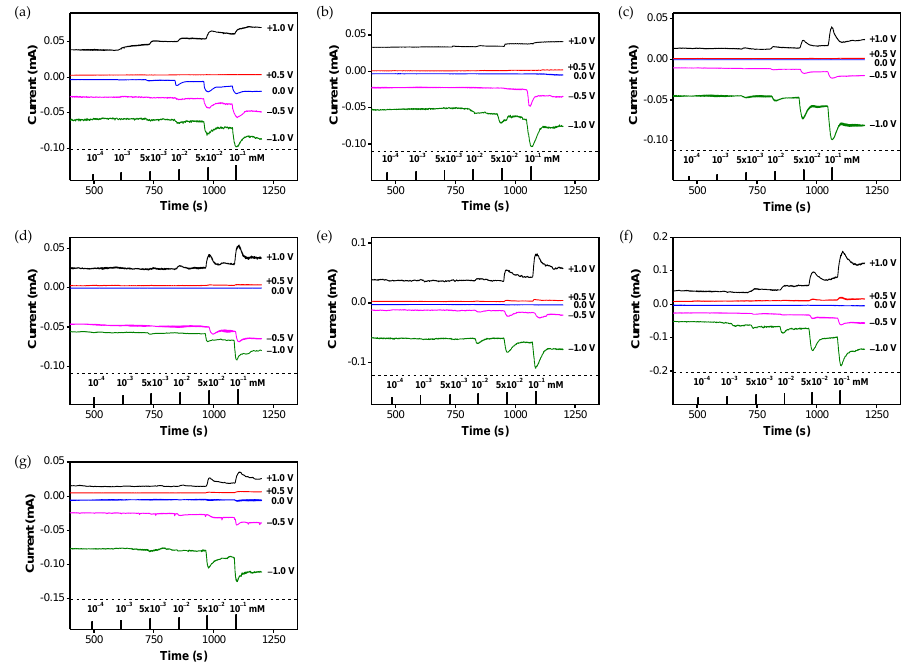
Figure 15. Real-time response of PPy/cellulose (PPCL) composite membranes in a flow cell measured at different applied potentials: ( a ) Hg(II); ( b ) Ag(I); ( c ) Pb(II); ( d ) Ni(II); ( e ) Cd(II); ( f ) Cr(III); and ( g ) Zn(II). Reprinted with permission from [152]. Copyright 2014, Royal Society of Chemistry.